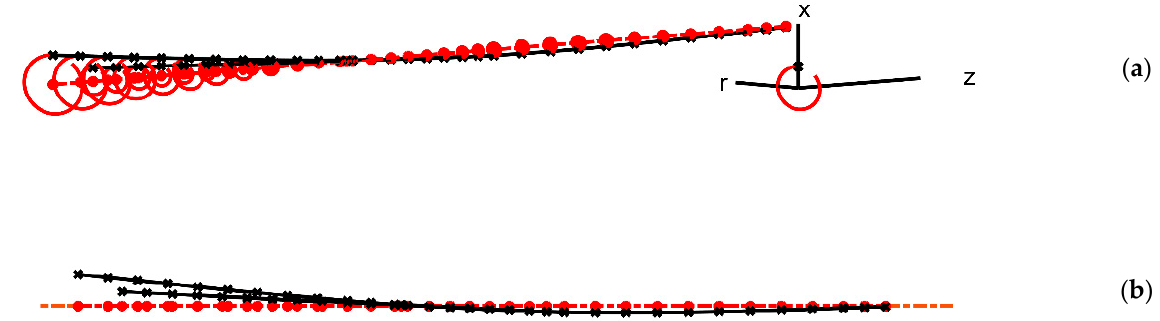
Figure 18. Mode shape: ( a ) 3D view; ( b ) 2D view.